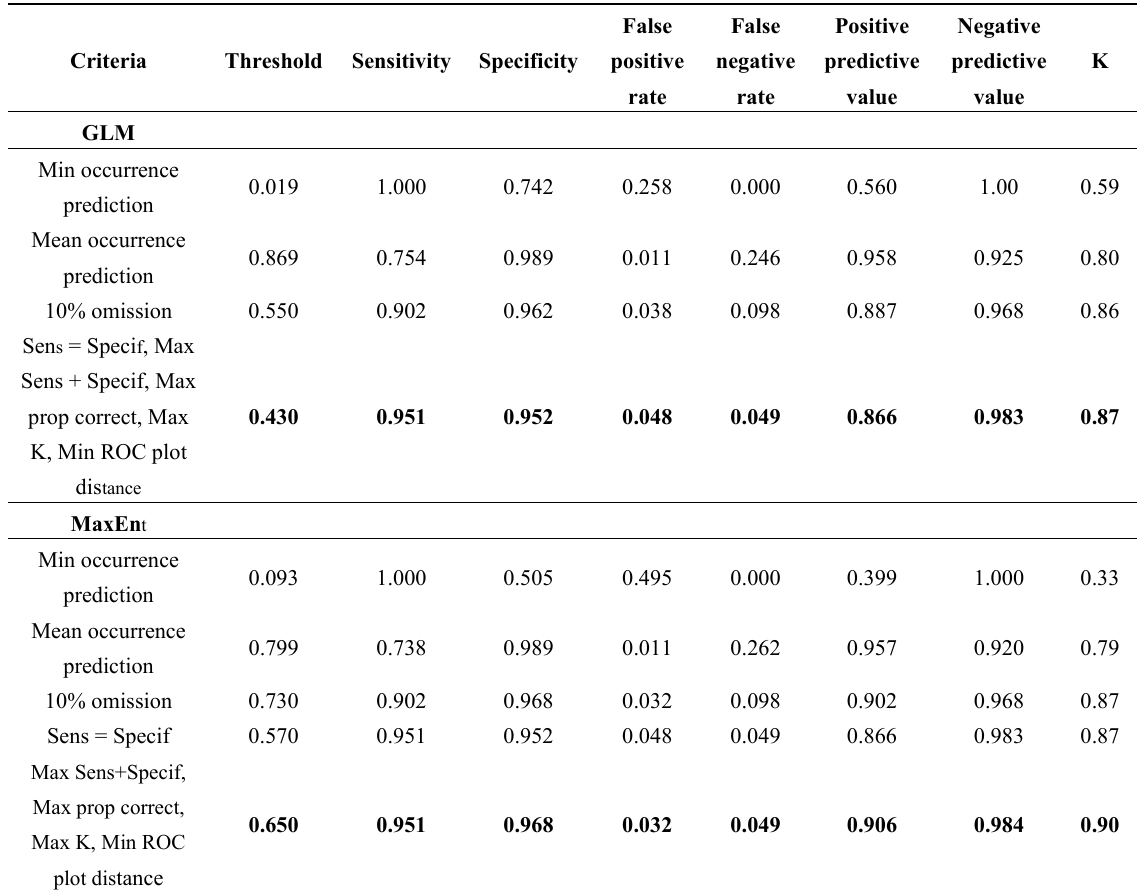
Table 3. Comparison of the models’ performance using different criteria for threshold selection. All criteria in the last line for generalized linear model (GLM) and maximum entropy algorithm (MaxEnt) predictions yielded the same cut-off probability. Min, minimum; Sens, sensitivity; Specif, specificity; Max, maximum; Max prop correct, maximum proportion of presence and absence records correctly identified; K, Kappa index; ROC, receiver operating characteristic.